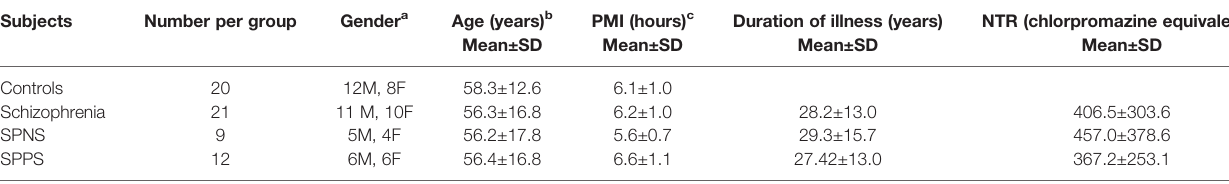
TABLE 1 | Demographic and clinical data (mean±standard